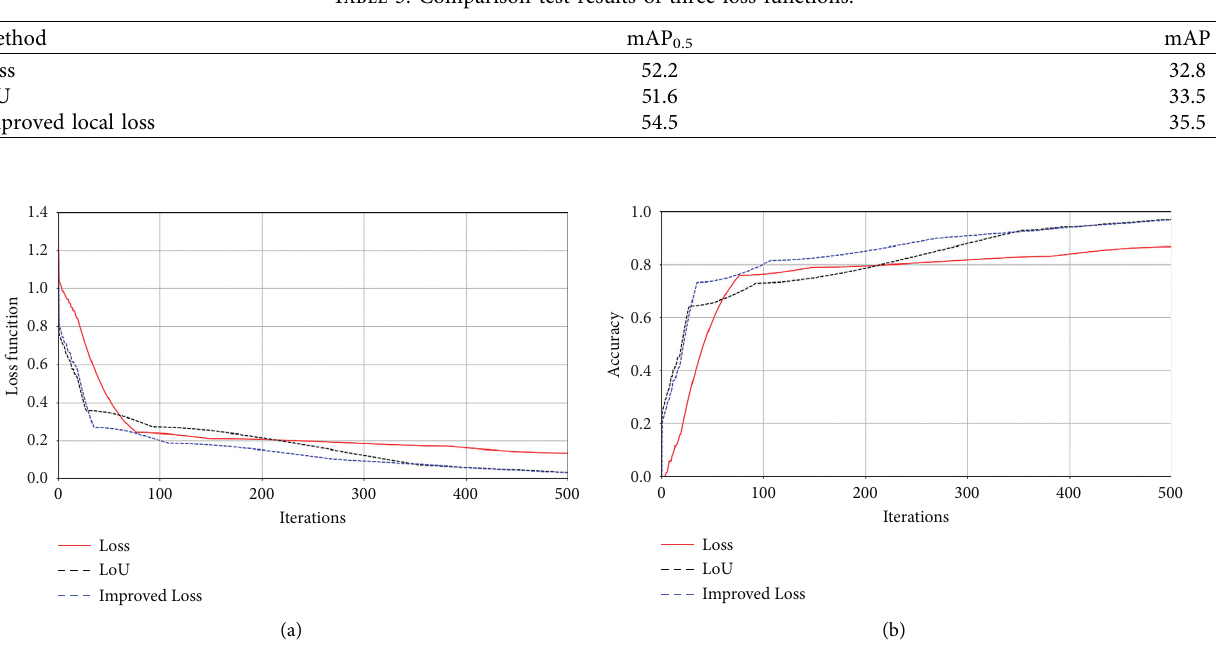
Figure 4: Curve of loss function and